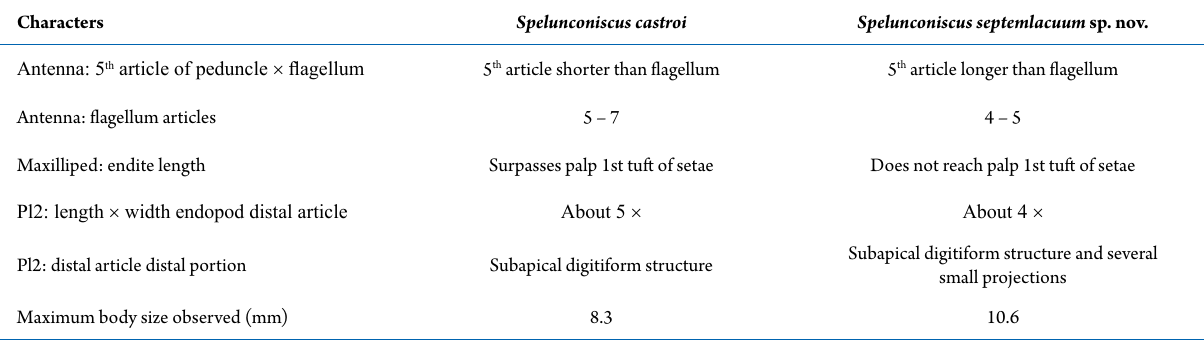
Table 1. Comparative table of distinctive morphological characters of Spelunconiscus (Styloniscidae, Oniscidea, Isopoda)